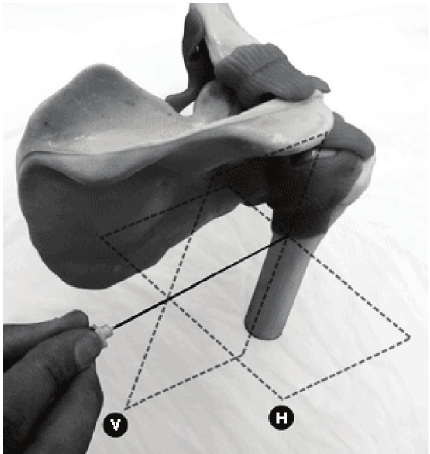
Figure 9: Anatomic representation of the Price technique. The hor- izontal axis (H) lies at the level of the quadrilateral space, where the axillary nerve passes beneath the glenohumeral joint capsule. The interception of the vertical axis (V) with the horizontal axis (H) allows location of the axillary nerve as it crossing the posterior neck of the humerus (Price [3]). (Reprinted with permission.)